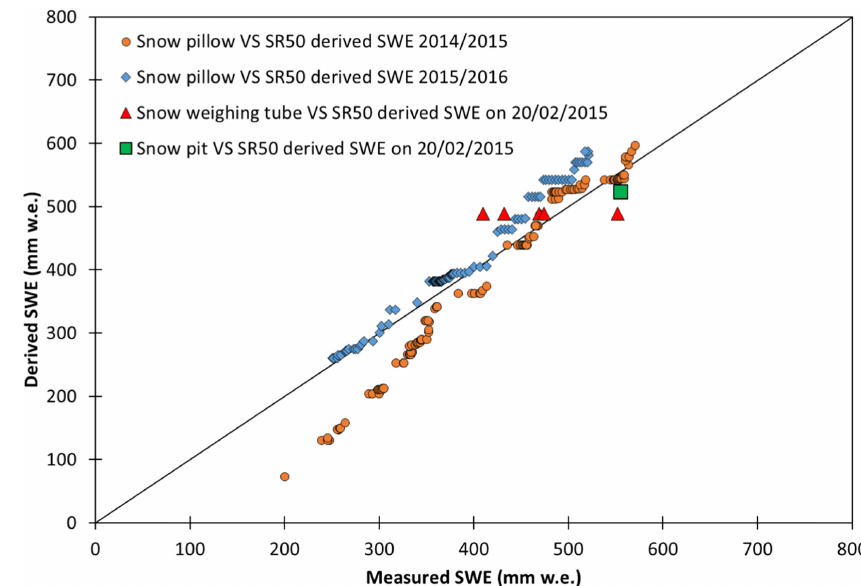
Figure 5. Scatter plots showing SWE measured by snow pillow and snow pit, derived by applying Eq. (4) to data acquired by Campbell SR50 (using the new snow density of 149kgm − 3 ). Two accumulation periods of measurements are shown from November 2014 to March 2015 and from February 2016 to May 2016. Every dot represents a daily value.